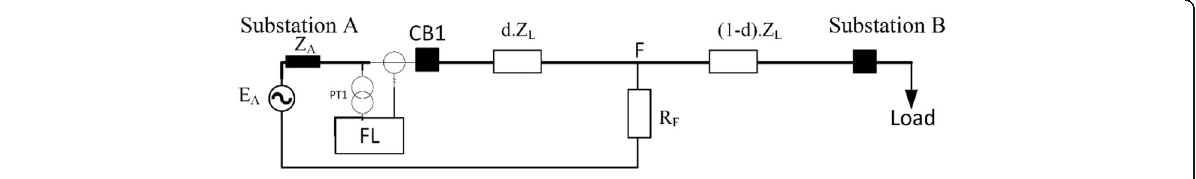
Fig. 1 Impedance based fault location with the source at one